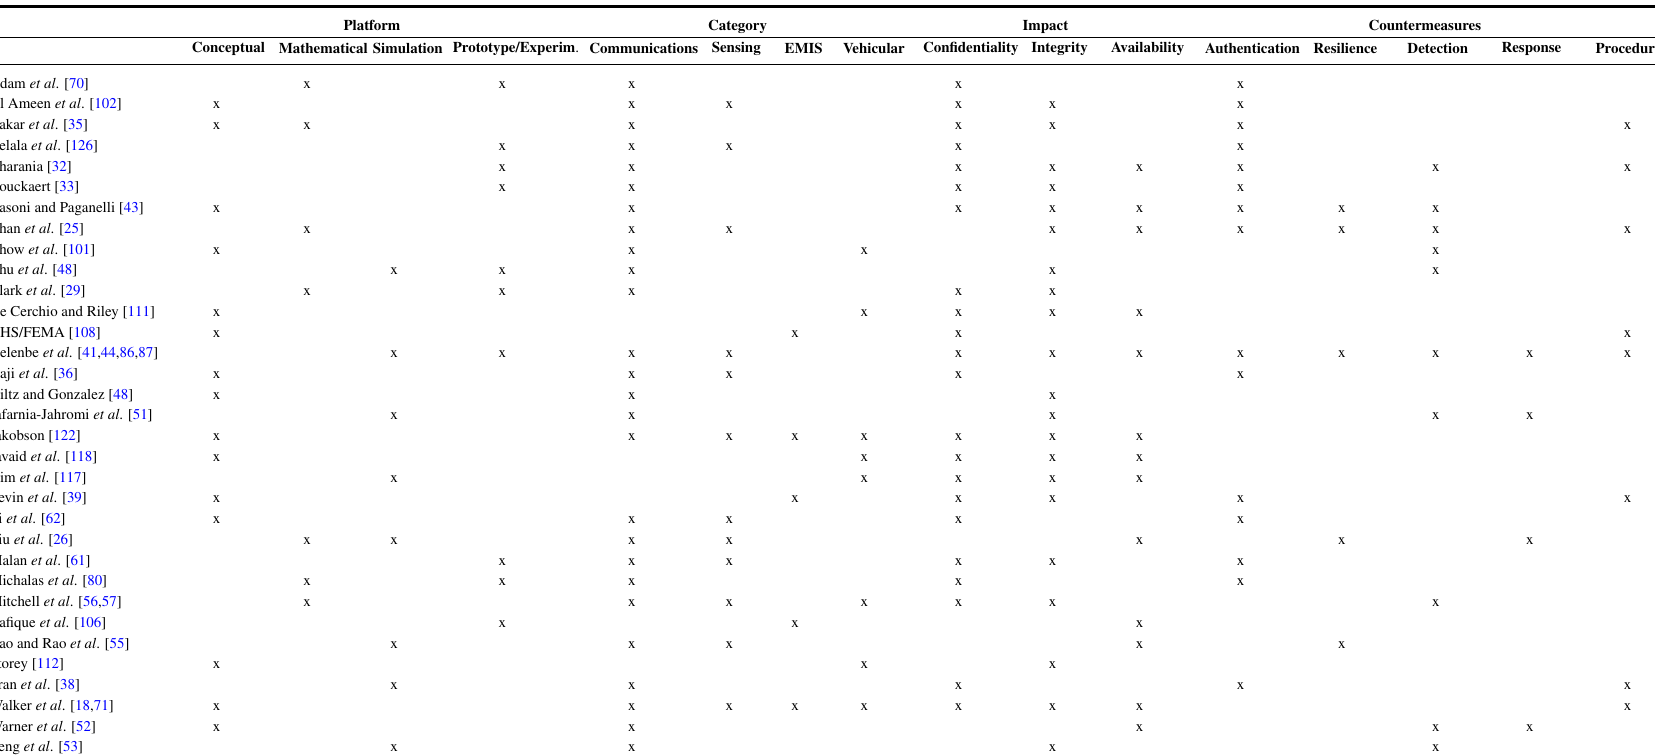
Table 5. Overview of research on analysis and countermeasures for EM cyber